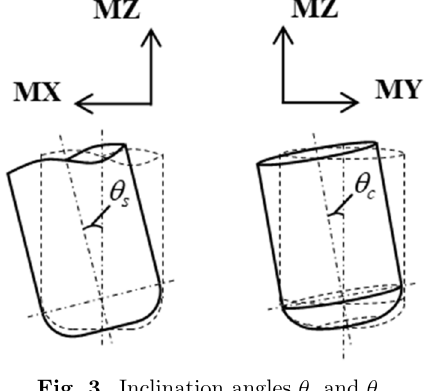
Fig. 3. Inclination angles u s and u c .